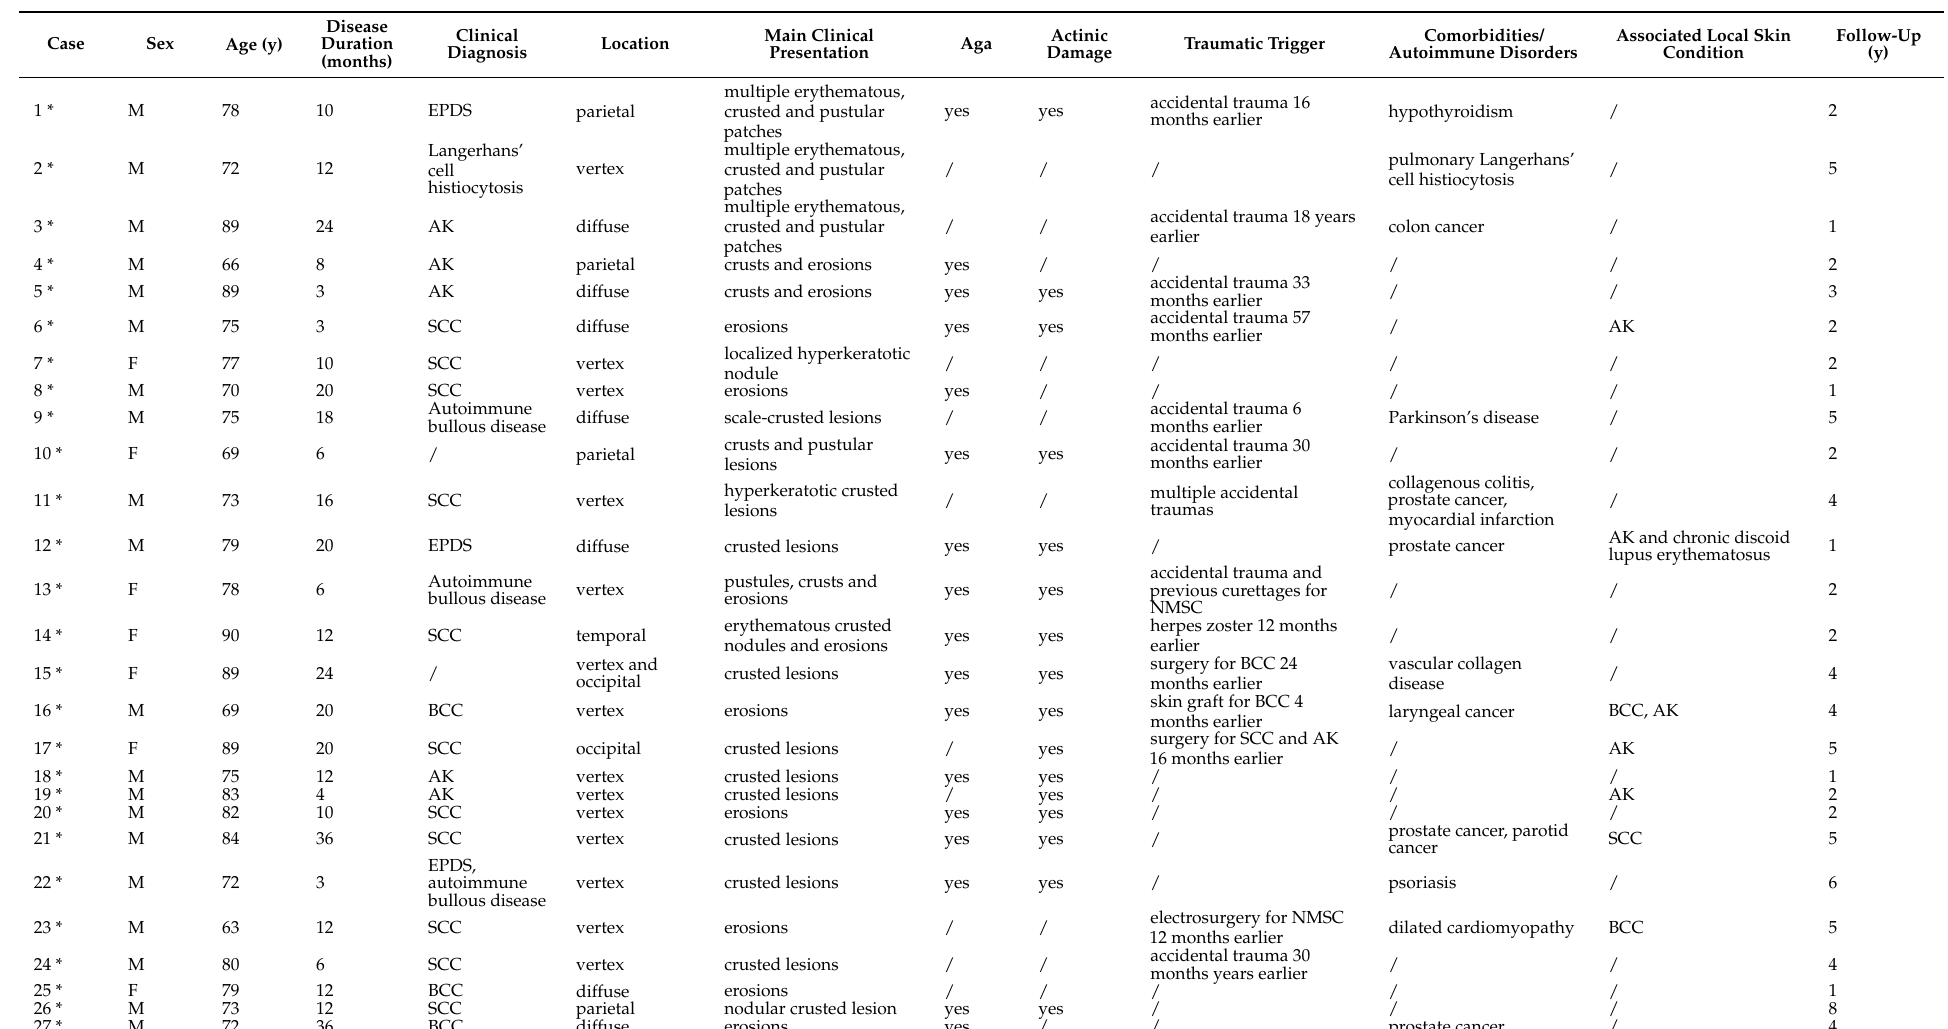
Table 1. Clinical data of our patients with erosive pustular dermatosis of the